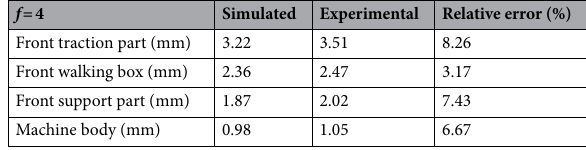
Table 9. Simulated and experimental vibration displacement values for parts when f =